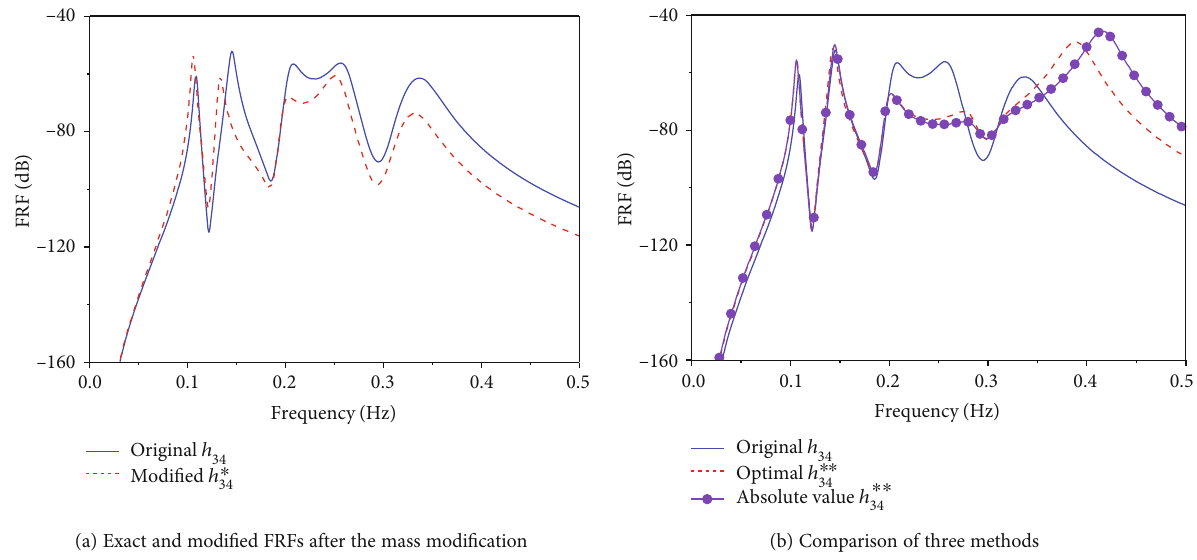
Figure 10: Comparison of FRFs between original and modi fi ed systems with modal damping ratio 2.52%.